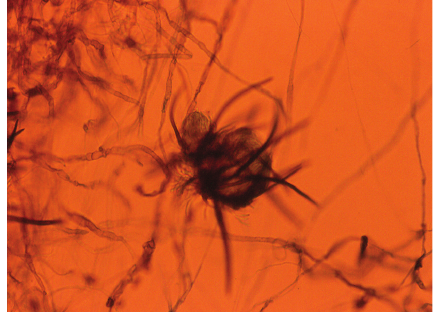
Figure 9: Chaetomium globosum isolated from a fungal keratitis in an agronomist patient ×